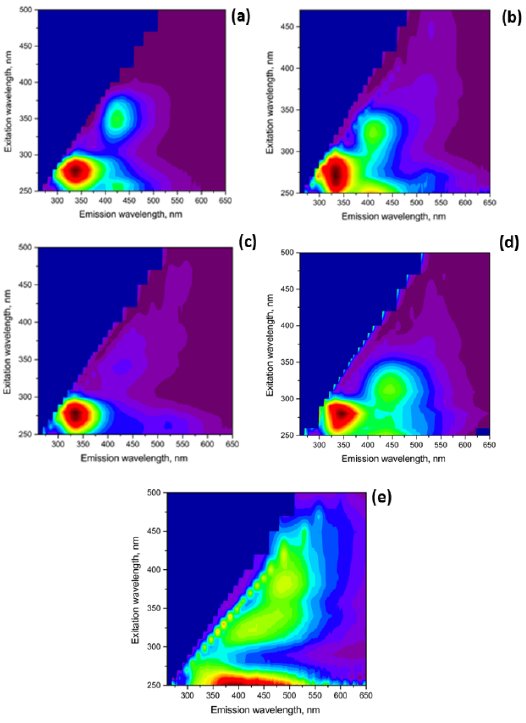
Figure 2. Excitation-emission matrix (EEM) of the fungal samples: ( a ) Alternaria alternata , ( b ) Cladosporium cladosporioides , ( c ) Fusarium solani , ( d ) Trichoderma harzianum , and ( e ) Aspergillus terreus . Note: the color reflects the fluorescence intensity. The fluorescence intensity decreases in the order of colors: burgundy—red - yellow - green - blue - dark